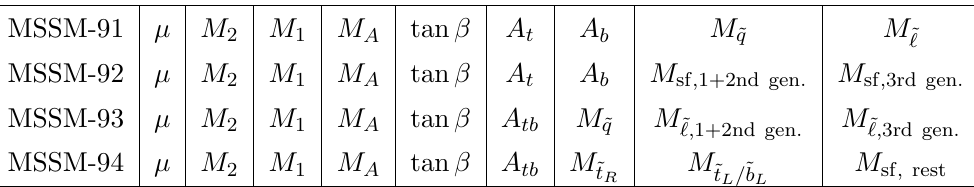
Table 4 . Free parameters for the four types of MSSM models considered in this work. Note that for the last two models we assume A t = A b